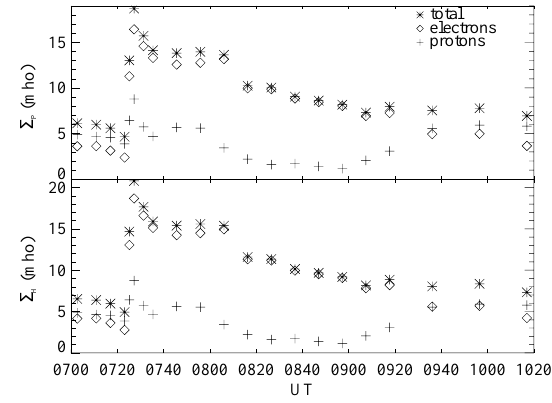
Fig. 7. Idem Fig. 6. In this example, the conductances are averaged over the midnight sector (MLAT between 60 ◦ and 65 ◦ and MLT between 23:30 and 00:30).